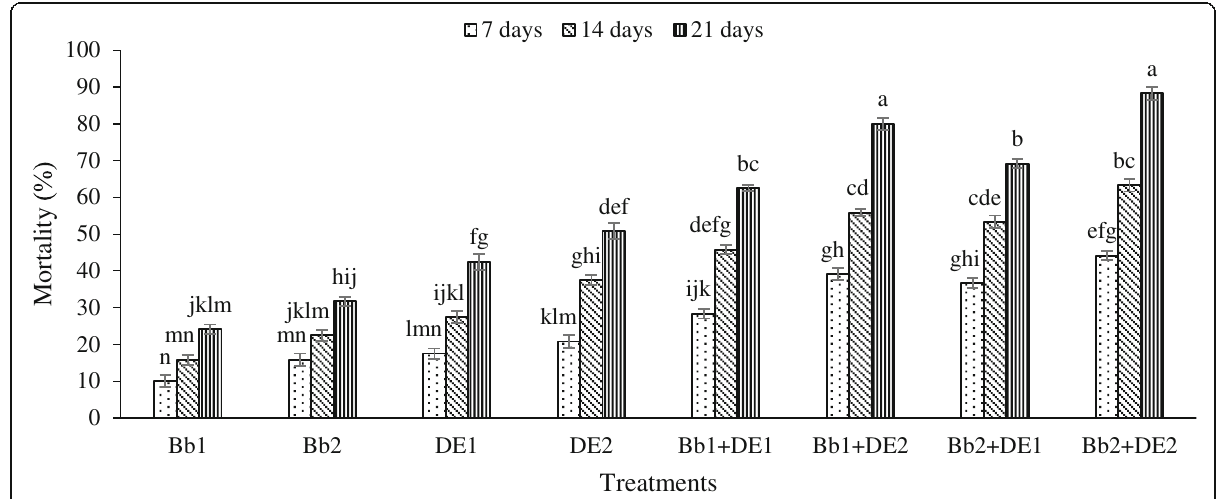
Fig. 1 Percent mortality (mean± SE, n = 3) of Tribolium castaneum in treated wheat with two concentrations of Beauveria bassiana (1 × 10 6 and 1 × 10 8 conidia kg − 1 of wheat) and DE (200 and 400 ppm) (alone and in combination) at weekly intervals